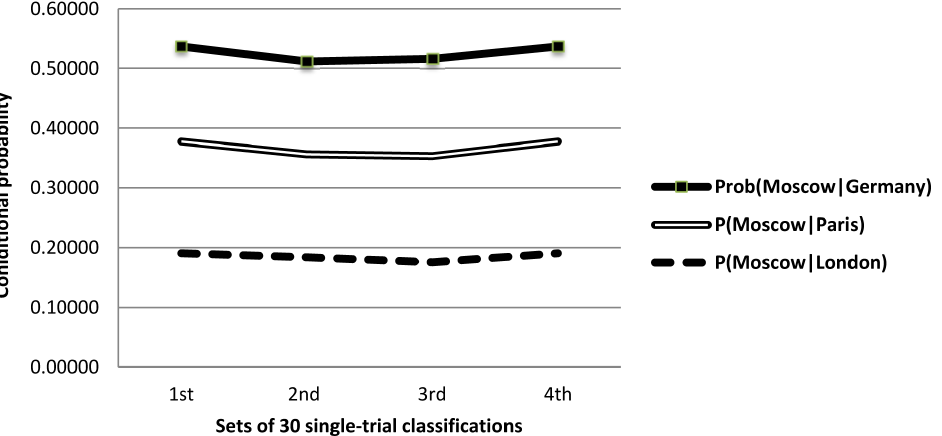
Figure 13. Probability that a test sample is classified as Moscow given that it is London (dash), Paris (double) or Germany (solid) over 4 sets of 30 single-trial classifications (S18) of the words { London,Moscow,Paris,north,south,east,west,Germany,Poland,Russia }.